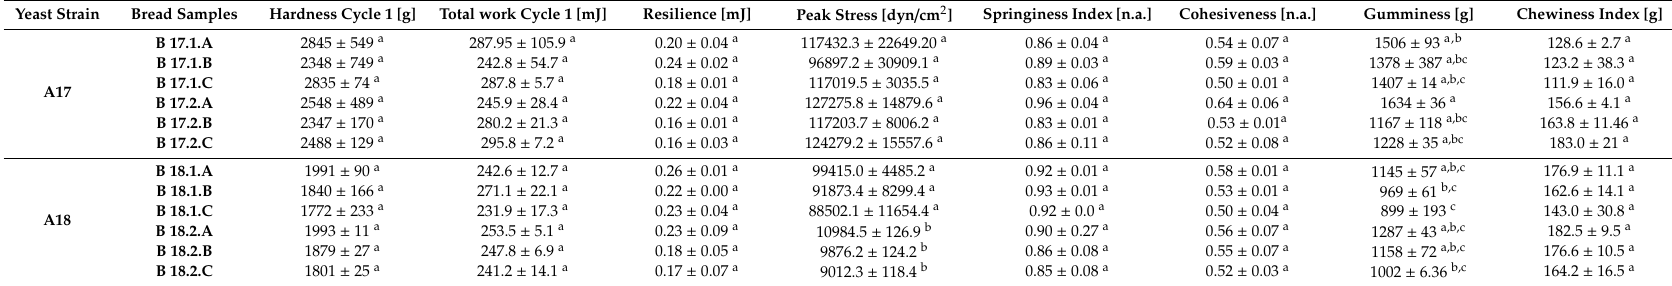
Table 2. Texture profile analyses for bread samples.